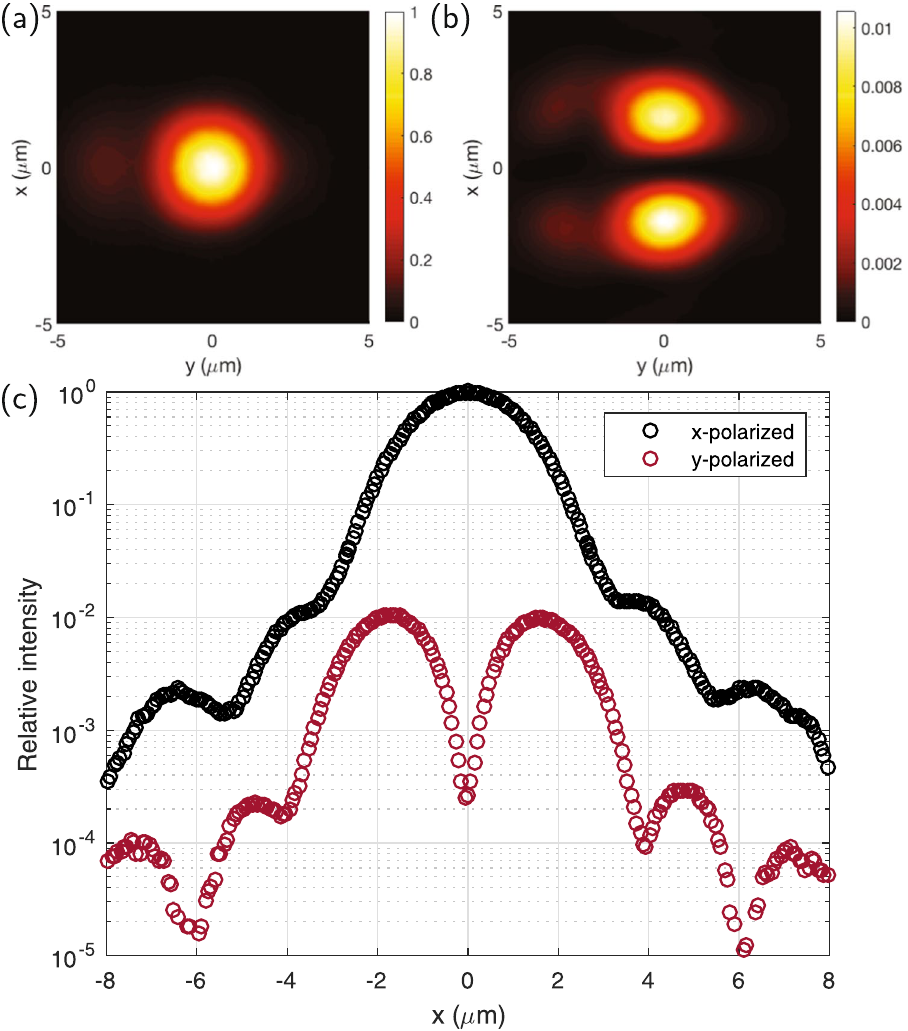
Figure 5. Measured intensity profiles when imaging ( a ) only the dominant x -oriented polarization and ( b ) the orthogonal transverse polarization (with the polarizer oriented along y ); color bars are scaled differently for each plot but correspond to the same scale. ( c ) Cross section along y = 0, showing intensity (relative to the peak of the x -polarized intensity) in each component along x ; black circles are points measured with the polarizer oriented along x , and red those with the polarizer oriented along y